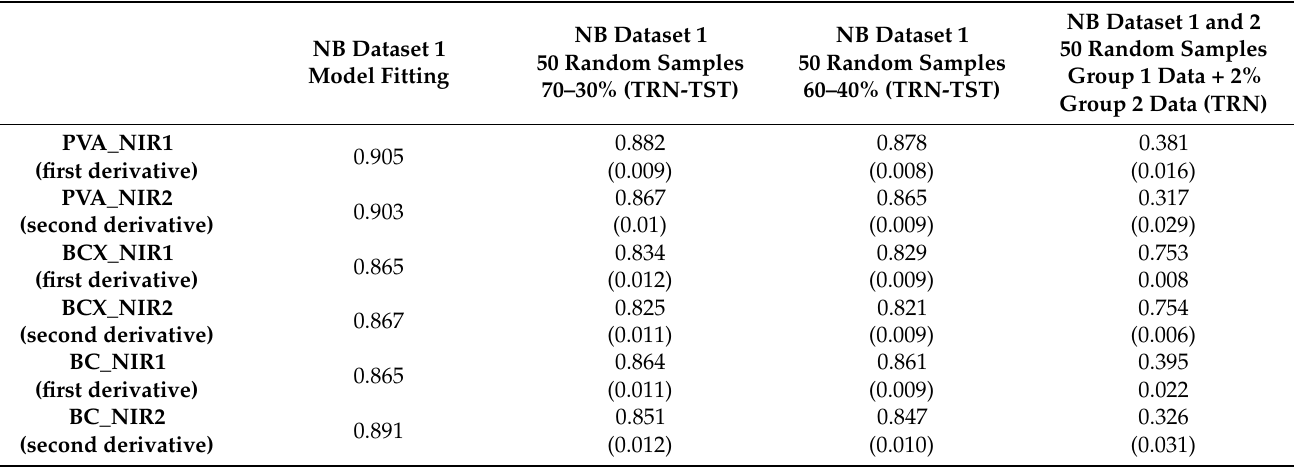
Table 1. Average Pearson predictive correlation PVA, BCX, and BC. Standard deviations (in parenthe- ses). Methods representing the NB = NIR BLUP for NIR1 and